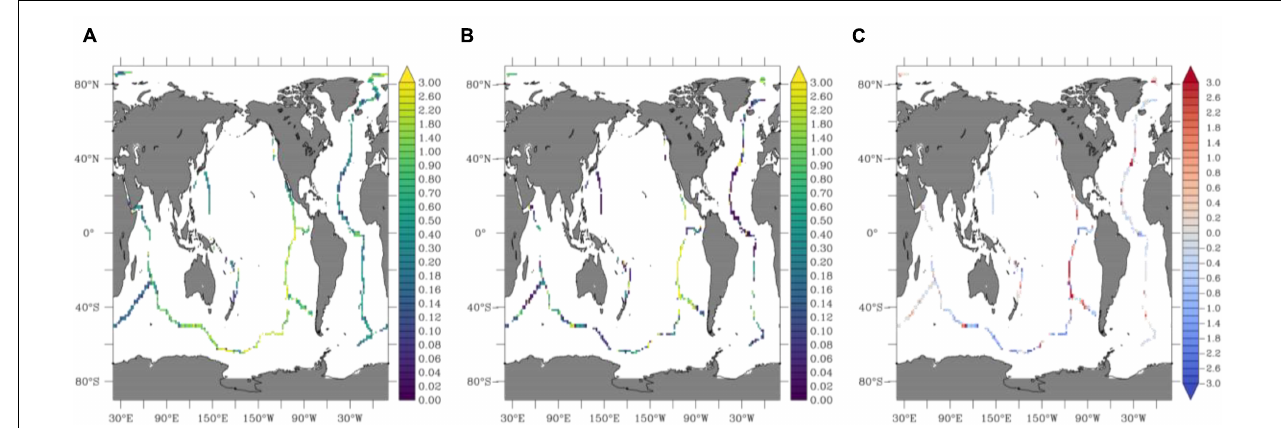
FIGURE 1 | Hydrothermal Fe input for (A) spreading and (B) inverse hydrothermal input experiments and (C) difference between inverse and spreading experiments, all in mmol Fe m − 2 yr − 1 .